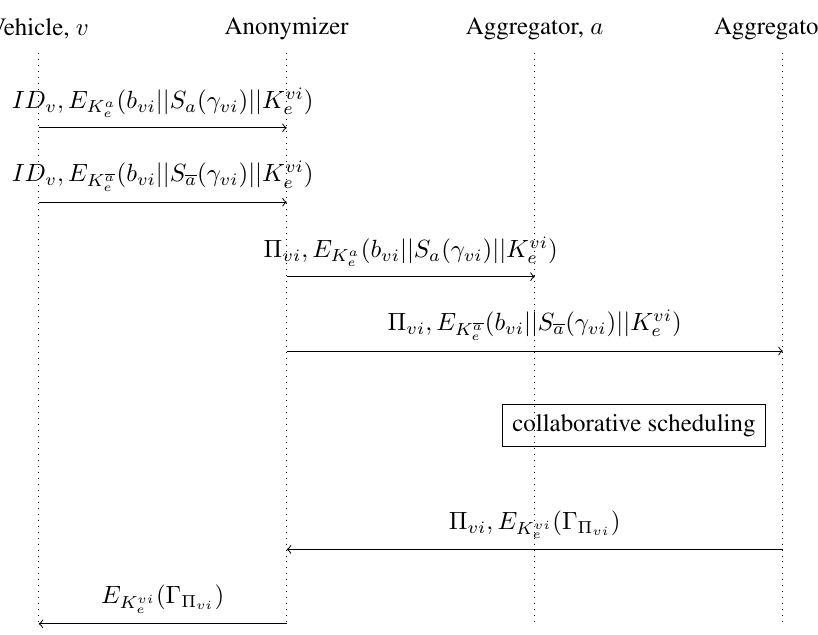
Figure 2. Data exchange during the battery charge/discharge scheduling